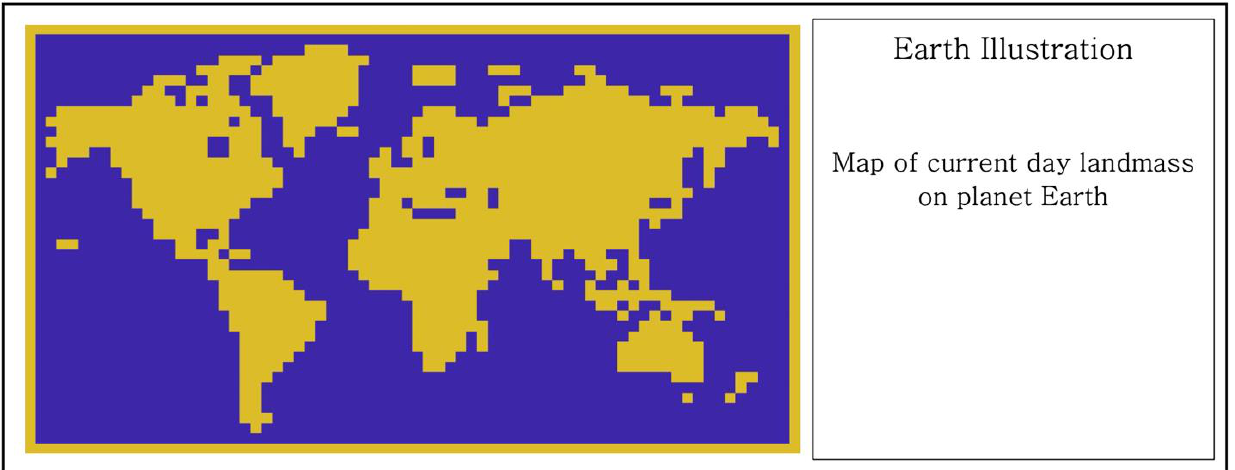
Figure 16. Map of the Earth in the message, Page 10.